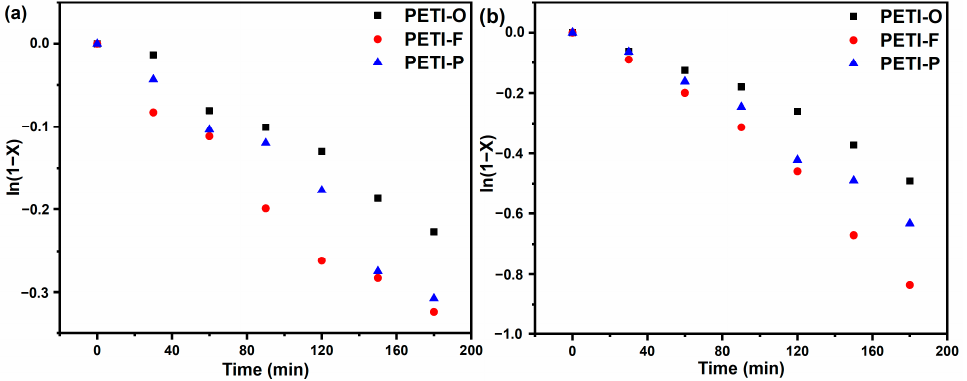
Figure 11. First-order rate plot of the time-dependant disappearance of the phenylethynyl groups at ( a ) 290 °C and ( b ) 300 °C.